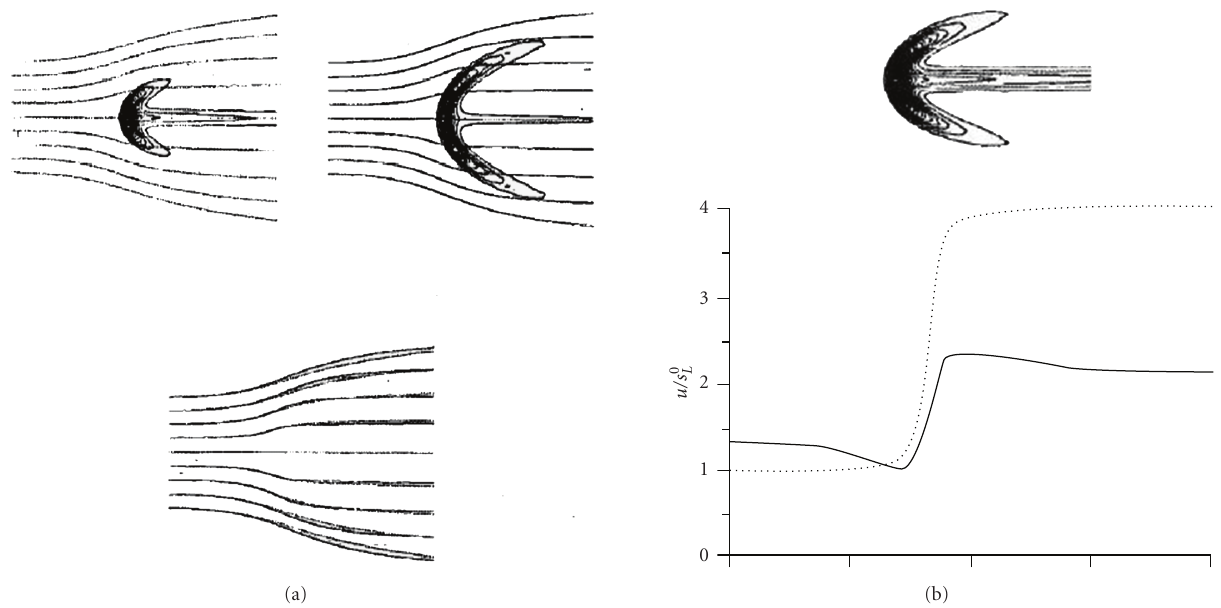
Figure 2: (a) Streamlines for triple flames with small and large mixing thicknesses. Reprinted by permission of the American Institute of Physics for Ruestch et al. [17], c (cid:2) 1995. (b) Contour lines of the reaction rate along with the horizontal velocity component at the stoichiometric or symmetry line for a stabilized triple flame (-) and planar premixed flame ( ... ). Reprinted by permission of the American Institute of Physics for Ruestch et al. [17], c (cid:2)